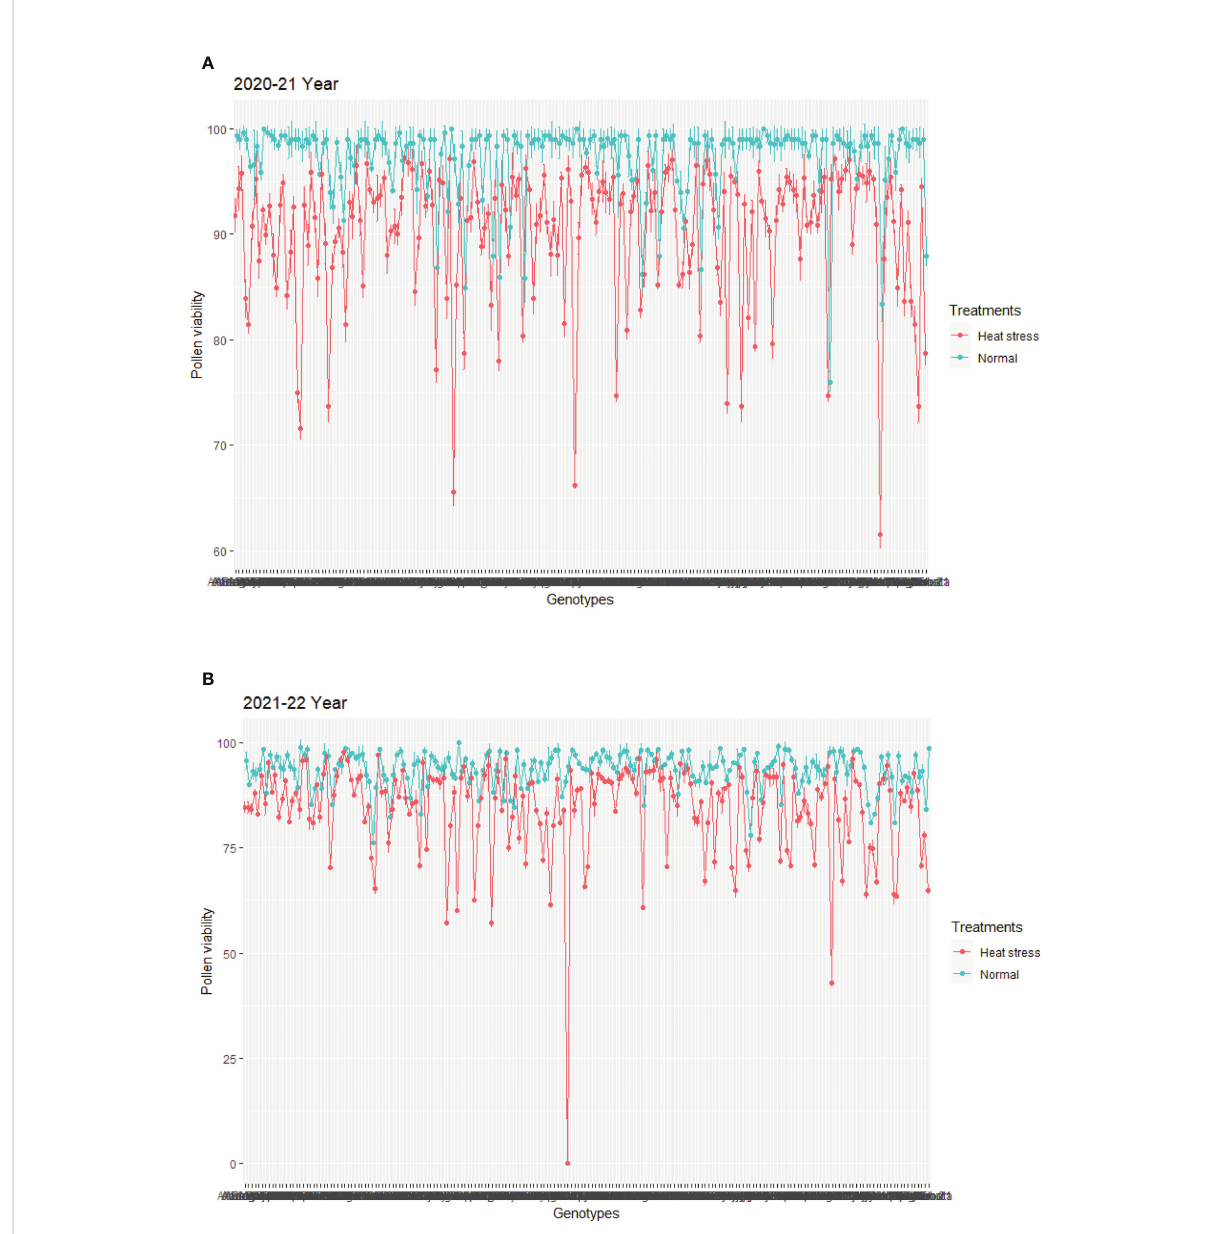
FIGURE 3 Line plot showing the effect of heat stress on pollen viability in 200 spring wheat genotypes during the period 2020 – 2021 (A) and 2021 – 2022 (B) . The error bars indicate standard deviation (SD) in pollen